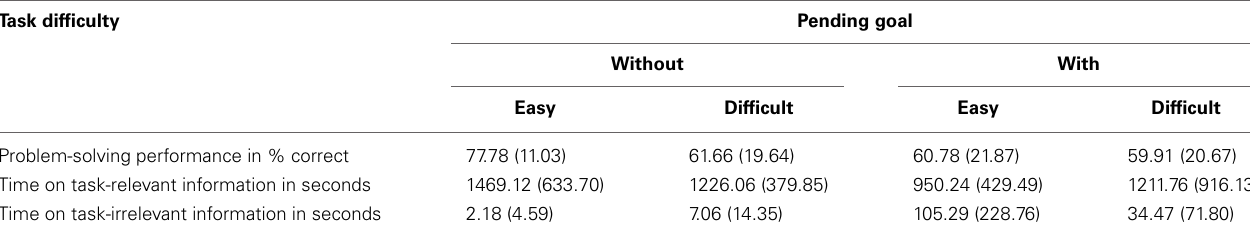
Table 5 | Means (and standard deviations) as a function of a pending goal related to interesting, task-irrelevant information and task difficulty (Experiment